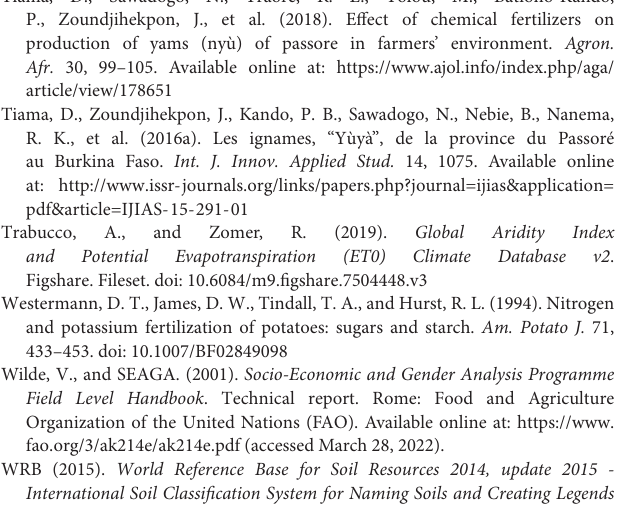
Figshare. Fileset. doi: